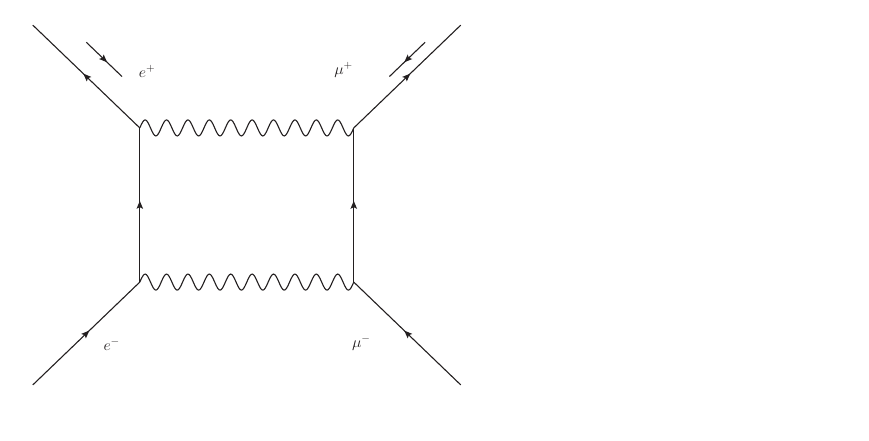
Figure 2. The box diagram related to the one-loop corrections to the process e + e − lines represent photons or Merlin particles and straight lines are